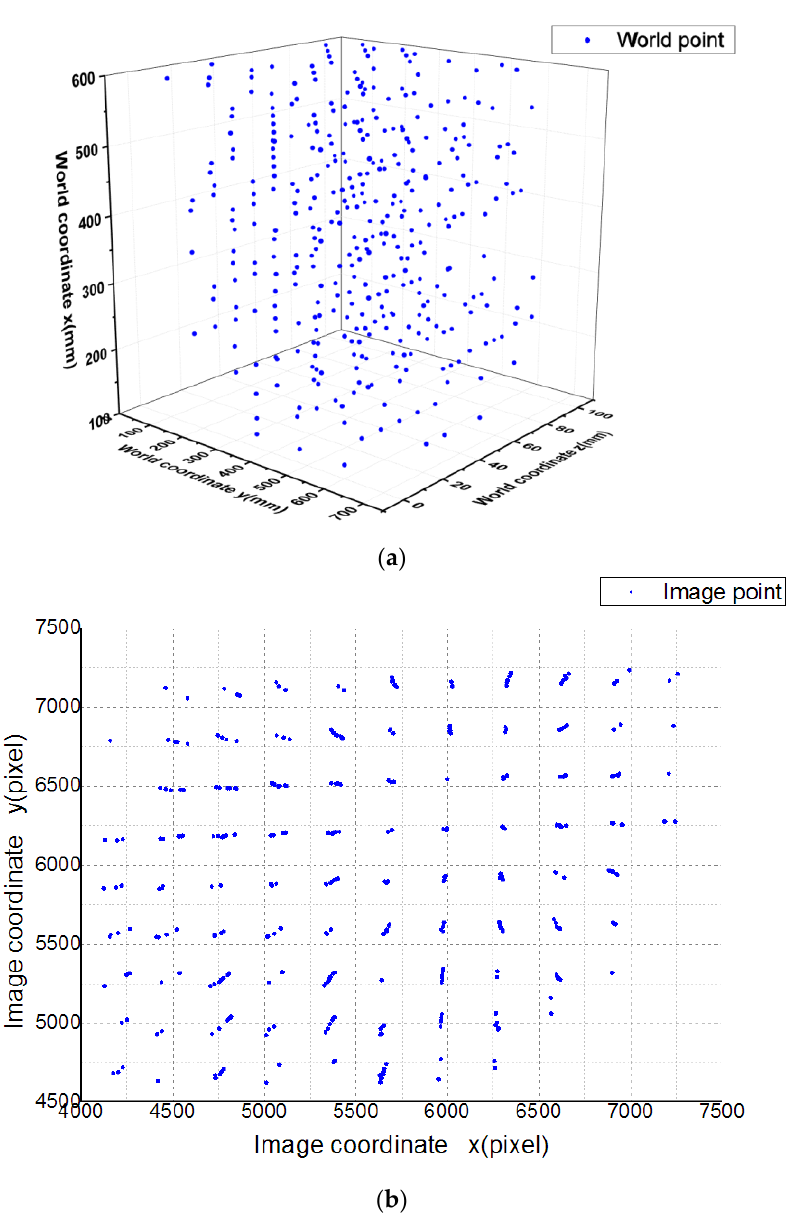
Figure 7. Test data set ( a ) is the world coordinate of the test dataset. ( b ) is the image coordinate of the test dataset.